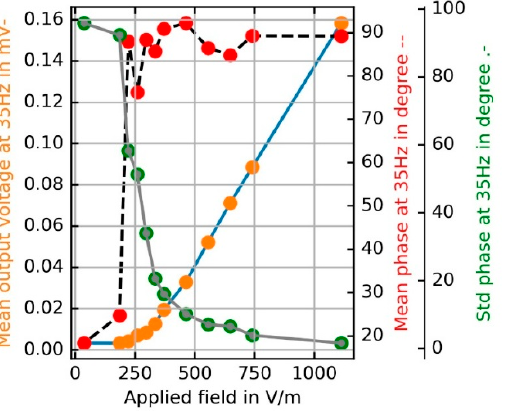
Figure 4. Evaluation of mean value and standard deviation from magnitude and phase information revealing the resolution limit of 222 V/m (at 35 Hz, far below the